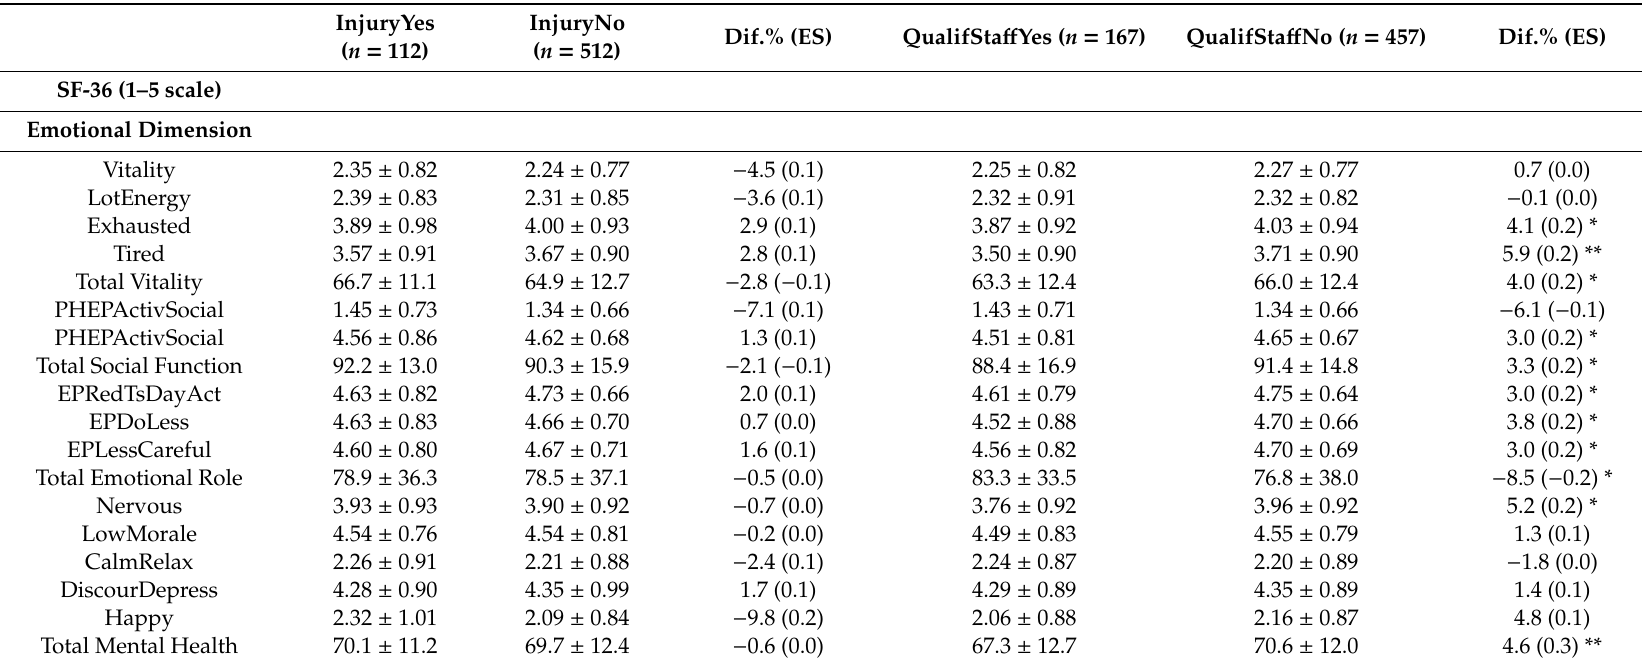
Table 5. Results obtained for the Emotional dimension of the SF-36 Questionnaire obtained by the amateur half-marathon runners participating in the study depending on whether they had su ff ered injury or not during the two months prior to participation in the race and depending on whether or not they had qualified sta ff for the preparation of the